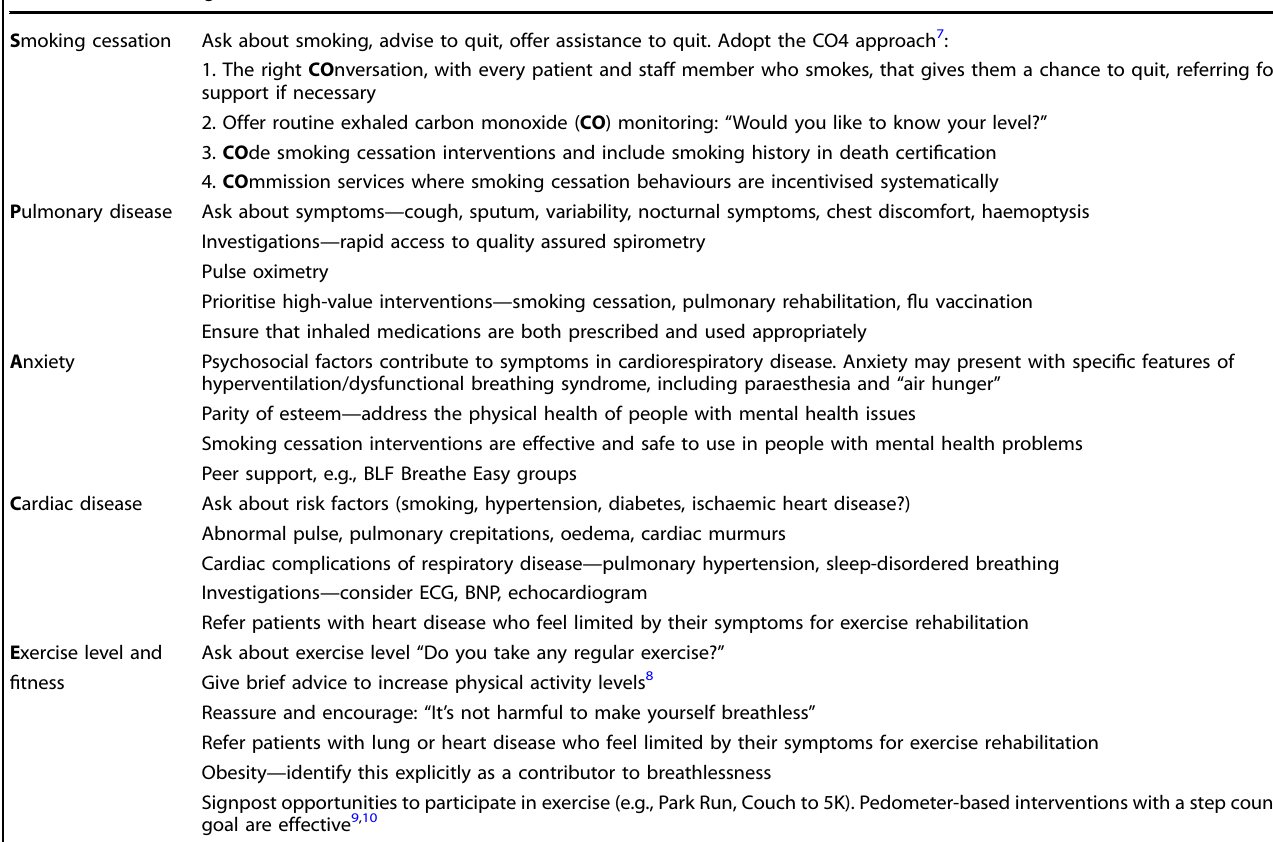
Table 1. The Breathing SPACE framework S moking